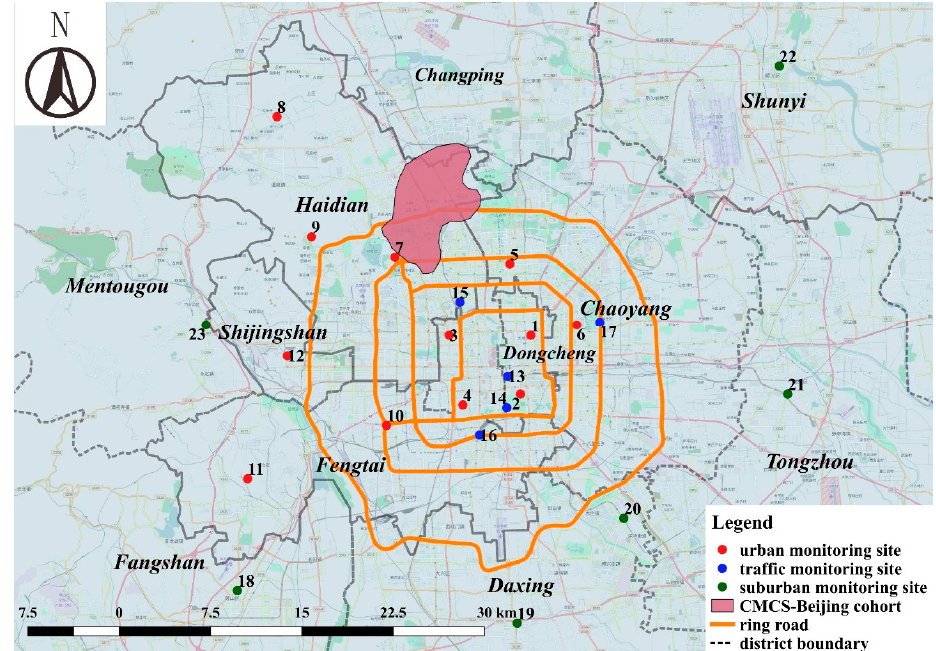
Figure 1. Map of Beijing showing the location of existing urban and suburban administrative air monitoring sites, and the location of the Beijing Chinese Multi-provincial Cohort Study cohort (CMCS-Beijing). Only 23 of the approximately 35 monitoring sites in the larger region are displayed. Monitor numbers correspond to those in Table 1. See Section 3.3 for a description of the CMCS–Beijing cohort. Map generated using QGIS (OSGeo, Beaverton, OR, USA) (www.qgis.org/). Table 1. Annual PM 2.5 and gaseous pollutant concentrations in 2015 for the individual administrative monitoring sites in central Beijing (see monitor locations in Figure 1). Monitoring Site PM 2.5 ( µ g/m 3 ) SO 2